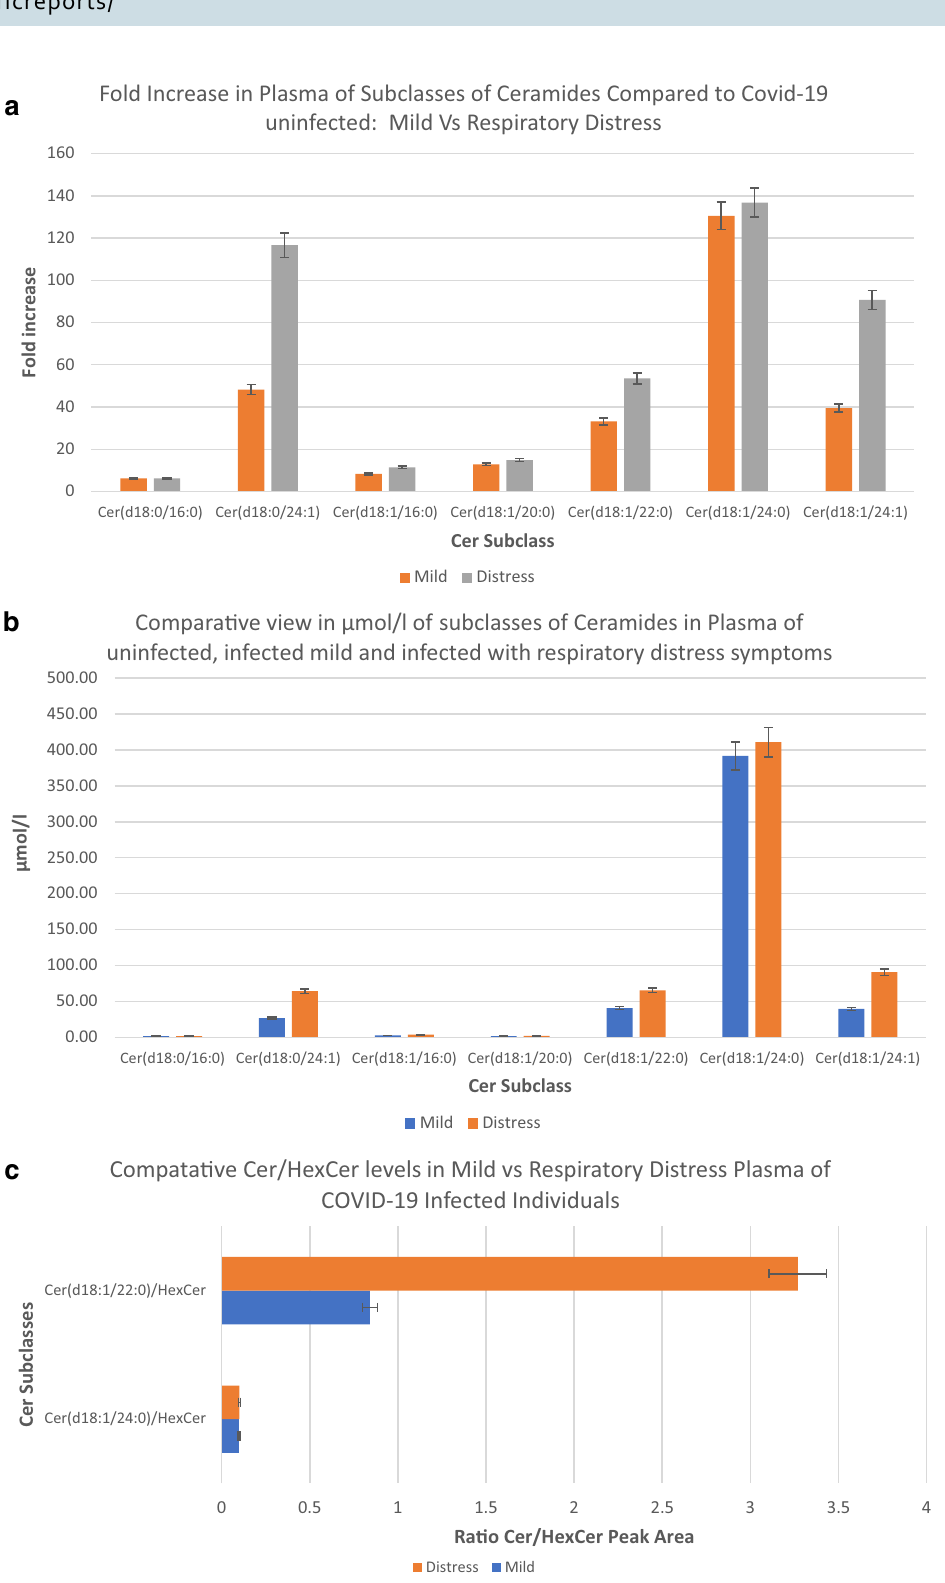
Figure 6. Ratios of lipids as predictive tests for respiratory distress. Abundance profile of subclasses of ceramides in the plasma of COVID-19 infected patients with mild and respiratory distress symptoms in terms of fold changes in observed peak area, compared to the plasma of uninfected individuals ( a ), Comparative view of changes in concentration of ceramide subclasses in the plasma of COVID-19-infected mild and with respiratory distress symptoms, from the uninfected, in terms of µmol/l ( b ), Relative abundance profile of subclasses of ceramides as represented by the ratio of peak areas of Cer/HexCer ( c ) and Cer/dhCer (Ceramide / dihydroceramide) ratios ( d ) in the plasma of COVID-19 infected patients with mild vs respiratory distress symptoms. Error bars represent, standard deviation of